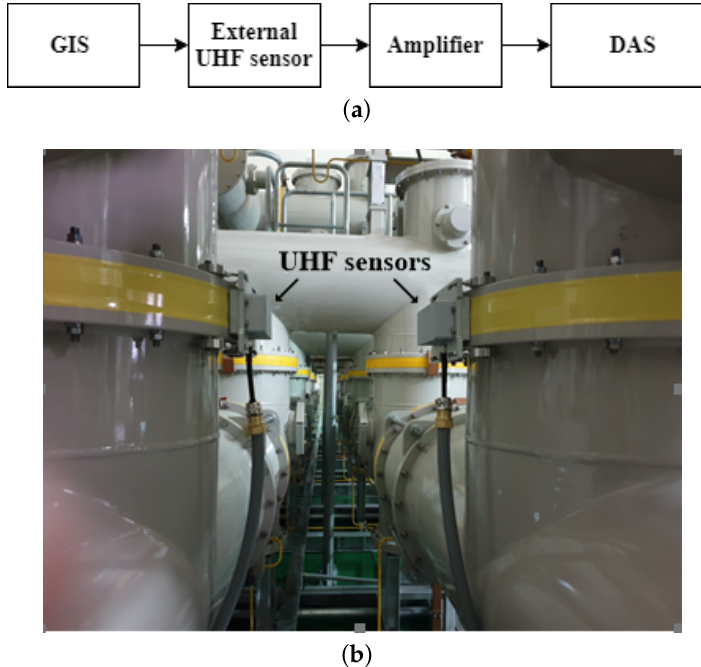
Figure 4. ( a ) A block diagram of PD measurement and ( b ) installation of ultra-high-frequency (UHF)